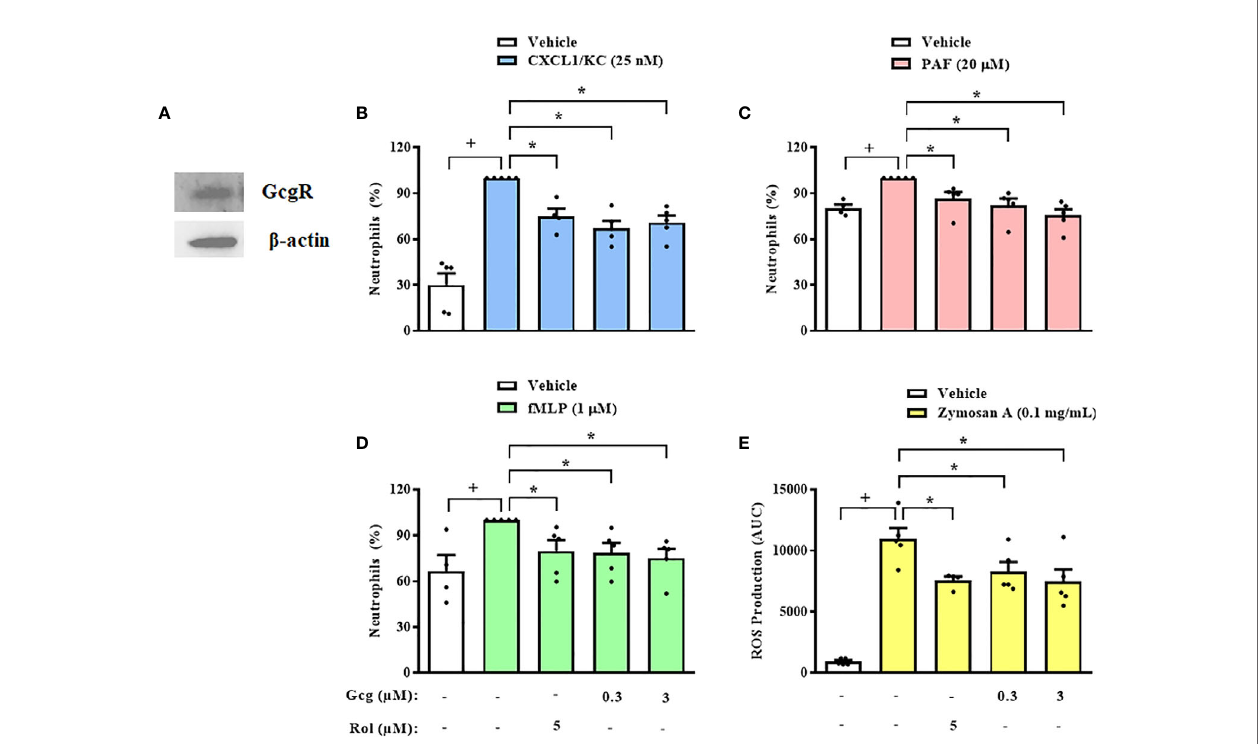
FIGURE 4 | Glucagon inhibits mice neutrophils chemotaxis and ROS production in vitro . (A) Representative sample of GcgR and b -actin expression in neutrophils obtained from mice BM. The expressions of GcgR and b -actin were determined by western blot. Results are representative of 3 animals. Full-length blots of GcgR and b -actin are reported in SM Figure S2 . (B – D) Effect of glucagon on CXCL1/KC- (25nM), PAF- (20 µM), or fMLP-induced (1 µM) chemotaxis of neutrophils isolated from mice BM in vitro , respectively. Cells were pretreated 30 min with glucagon, rolipram or vehicle in vitro and then let to migrate for 40 min towards stimulus in a chemotaxis chamber. (E) ROS production by BM-neutrophils in vitro . Cells were pretreated 30 min with glucagon, rolipram or vehicle in vitro and then stimulated with zymosan A (0.1 mg/mL) for 1 h. The vehicles used were DMSO 0.1% or medium to rolipram and glucagon, respectively. Each value represents the mean ± S.E.M. from 5 animals. The statistical analysis was performed by one-way ANOVA, followed by Newman – Keuls – Student ’ s t-test. Results from (B – E) are representative of three individual assays. Results from (A) are representative of one individual assay. + P < 0.05 compared to non-stimulated cells. * P < 0.05 compared to stimulated cells. Gcg, Glucagon; Rol,